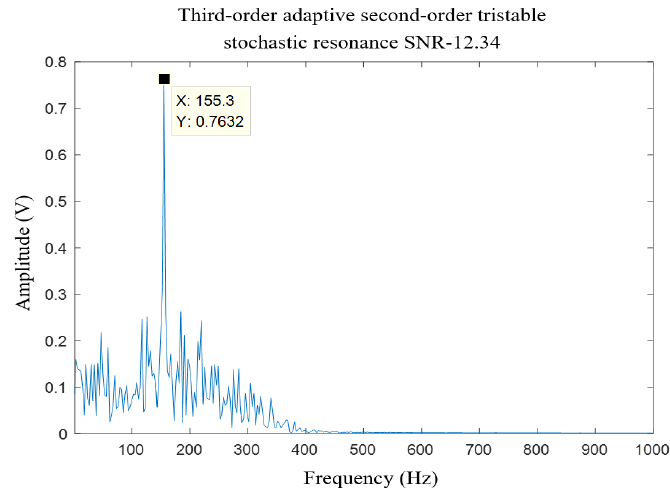
Figure 18. The output spectrum of the third cascade system.